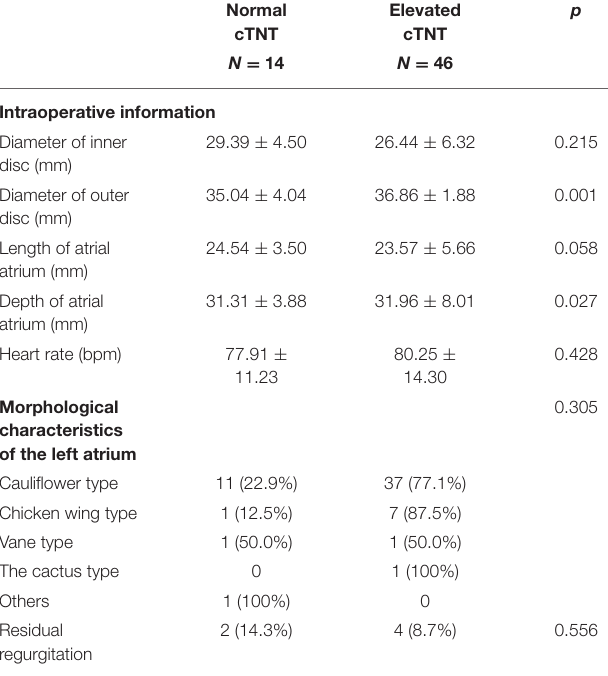
TABLE 4 | Information of the Lambre group.